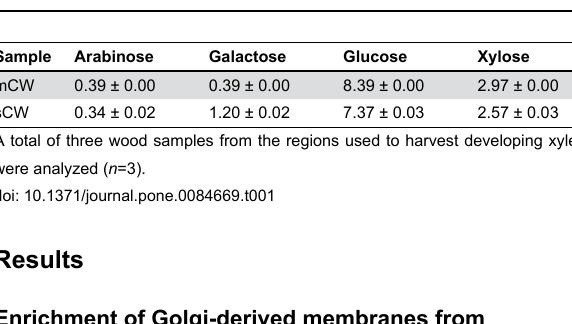
Table 1. Neutral sugar analysis (mM) of mild and severe compression wood